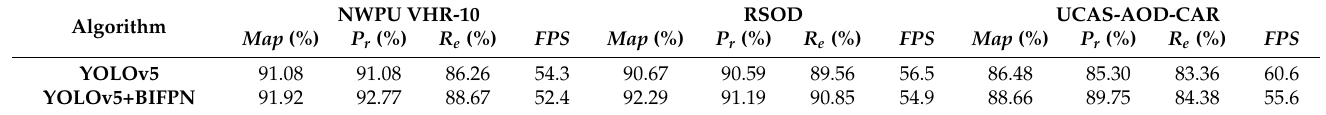
Table 4. Effects of the bidirectional feature pyramid network framework on three different datasets.